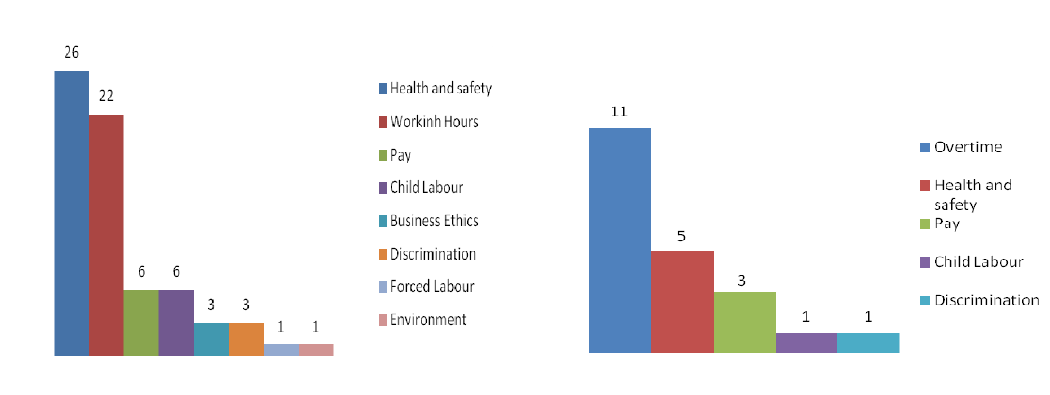
Source: Corporate Social Responsibility - complete report by France Telecom Orange,